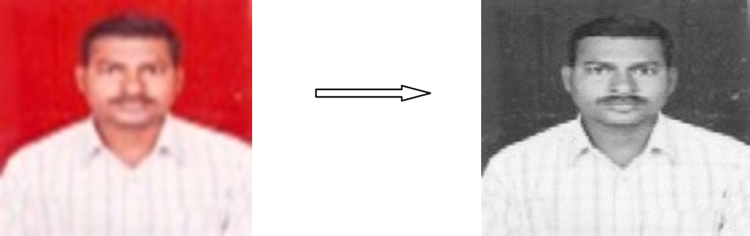
Convert RGB to gray.